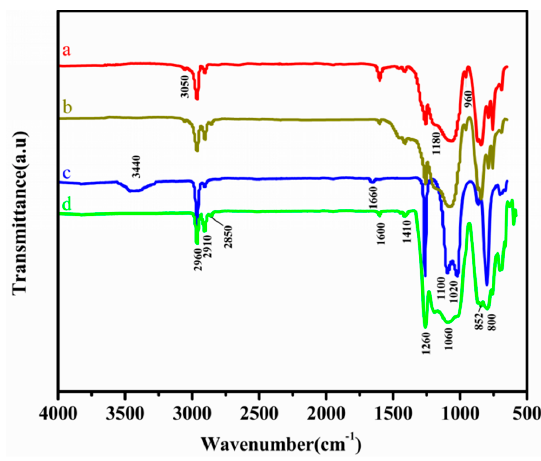
Figure 2. Infrared spectra of ( a ) vinyl–MQ (VMQ), ( b ) MMQ, ( c ) HPDMS and ( d ) RTV silicone rubber (MMQ-1).